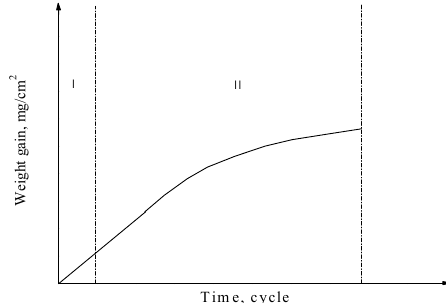
Figure 10. Stages of the corrosion process: ( I ) interface reaction is the controlling step; (II) diffusion reaction is the controlling step.